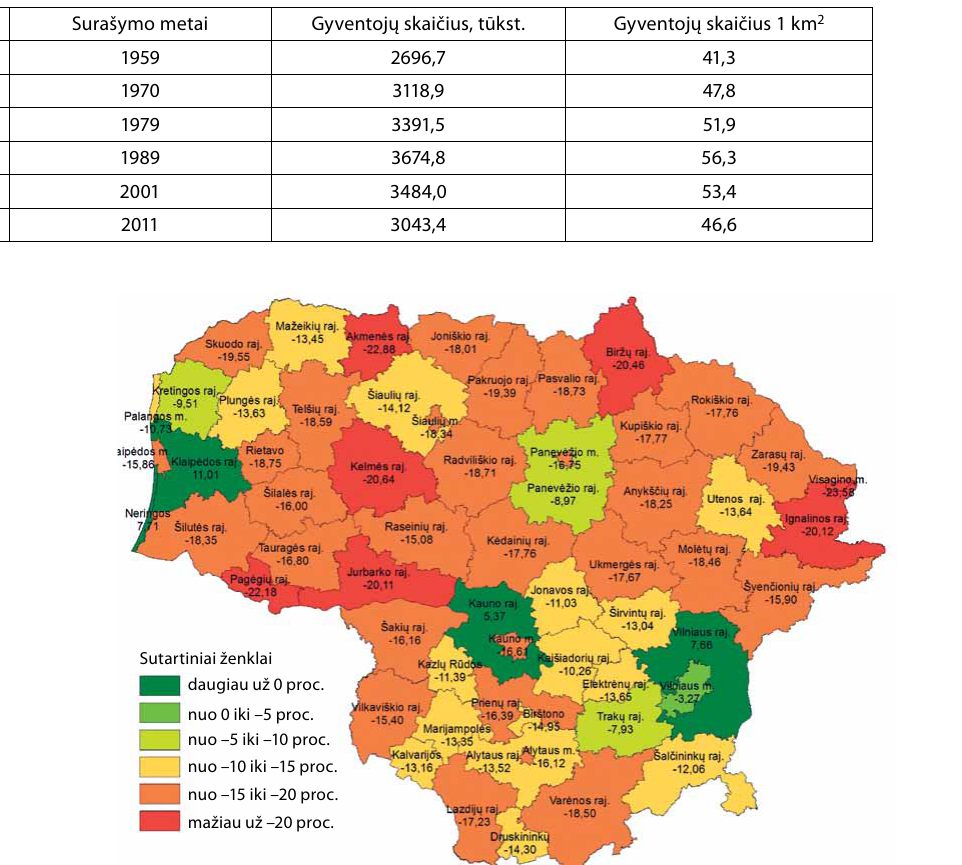
fig. 4. The change of popultaion in municipalities (%) 2001-2011 (according analysis of lithuania statistics department results of Census of population and housing in2001-2011 of the republic of